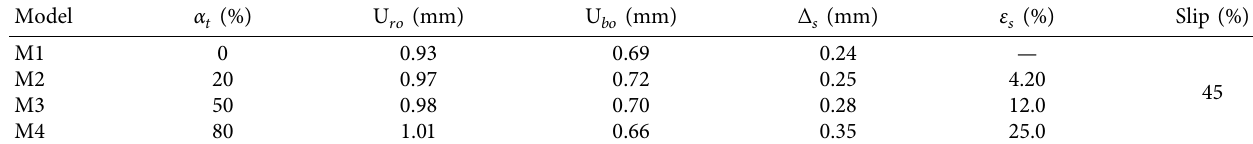
Table 7: Comparison of displacement and slip in the frst cycle of the used FE model.